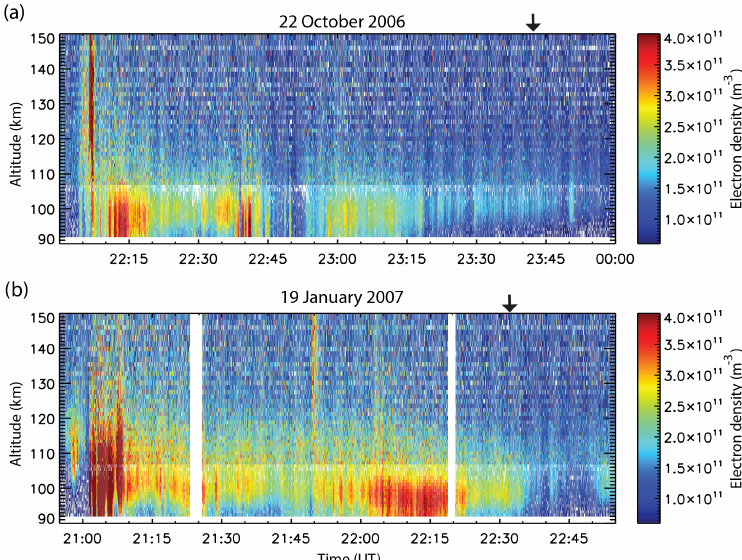
Figure 1. (a) Electron density measurements in magnetic zenith from the Tromsø EISCAT radar on 22 October 2006. The substorm onset at 22:07UT is seen as the strong ionisation enhancement from 90km up to above 150km altitude, and it is followed by 2h of hard precipitation with ionisation below and at 100km altitude, during which diffuse pulsations are seen in the optical data. (b) Same format as in (a) , but for 2h on 19 January 2007. Substorm onset is at